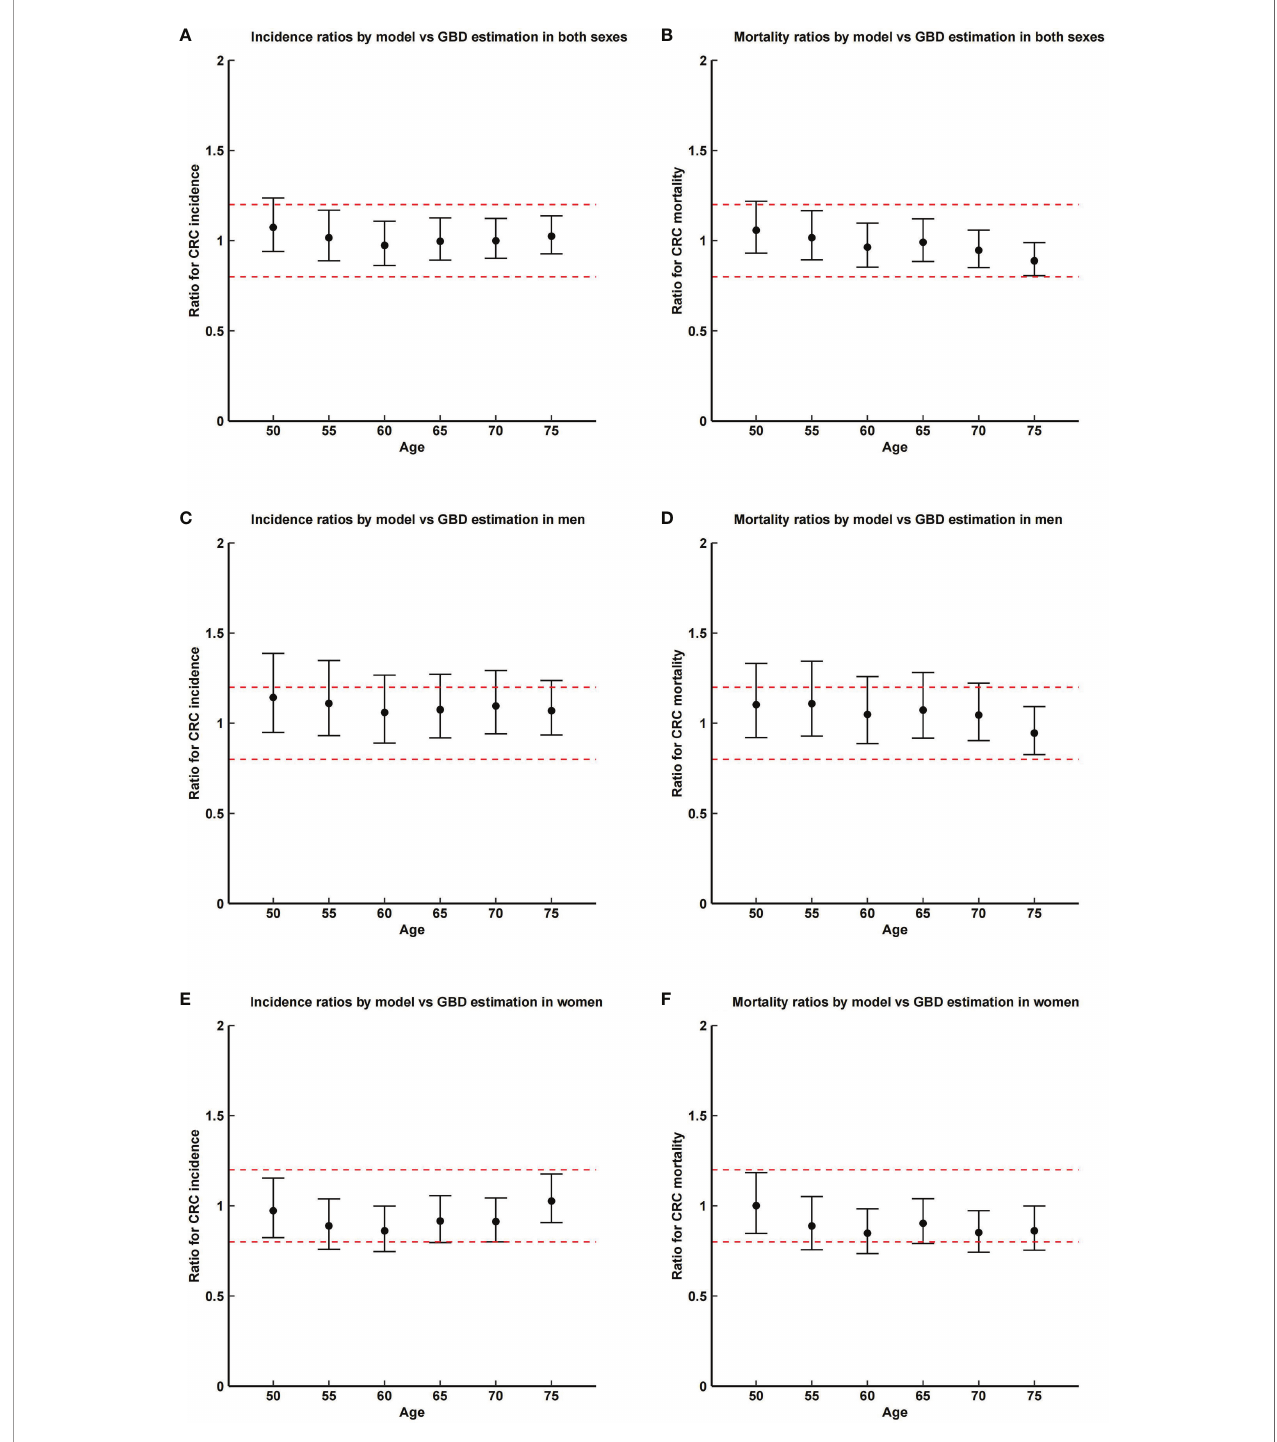
FIGURE 3 | Ratios and corresponding CI of model-predicted incidence and mortality of colorectal cancer with the registry-based estimations in China in 2015. Dashed lines show the margin of testing for equivalence (0.2). GBD, global burden of disease. (A) incidence ratios by model vs. GBD estimation in both sexes; (B) mortality ratios by model vs. GBD estimation in both sexes; (C) incidence ratios by model vs. GBD estimation in men; (D) mortality ratios by model vs. GBD estimation in men; (E) incidence ratios by model vs. GBD estimation in women; (F) mortality ratios by model vs. GBD estimation in